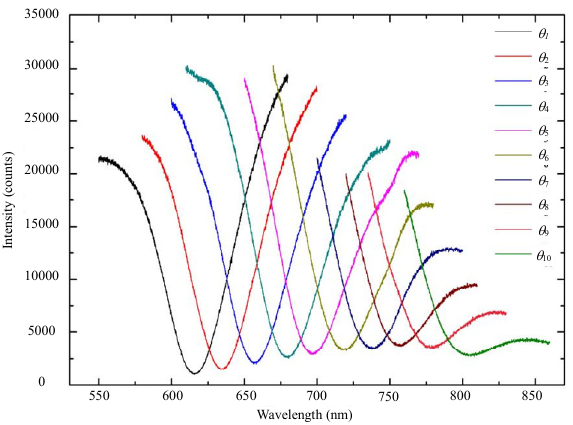
Fig. 13 SPR measurement curves acquired by USB4000 spectrometer (the reflectivity curves from left to right correspond to incident angles θ 1 , θ 2 , θ 3 , θ 4 , θ 5 , θ 6 , θ 7 , θ 8 , θ 9 , and θ 10 , respectively).